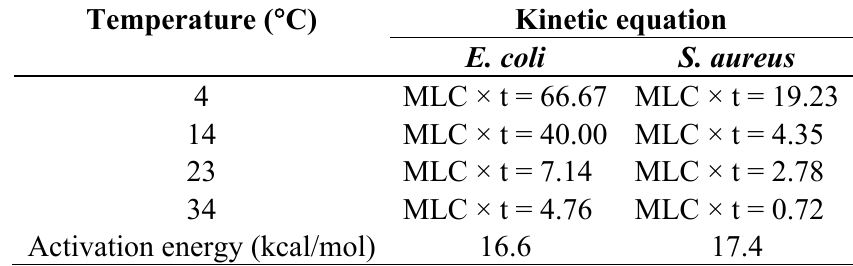
Table 2. Kinetic parameters of the dialdehyde starch aqueous suspension against